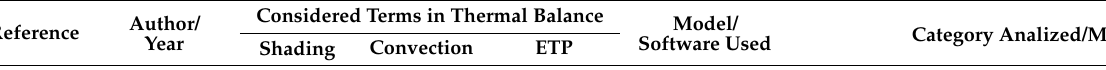
Figure 1. Proposed classification of VGS. Effects on buildings are specified for each category.